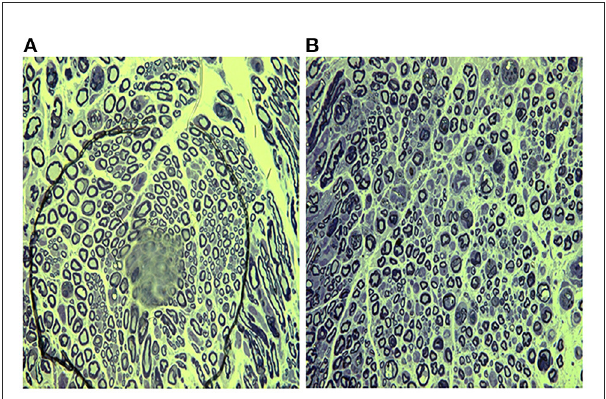
FIGURE3 Transmission electron micrographs showing the ultrastructure of brachial plexus day 7 after injury. (A) Vehicle group; (B) melatonin group. Nerves in the melatonin group showed thicker myelin sheaths and narrower endoneural gaps compared to the vehicle group. Scale bar = 5 mm.